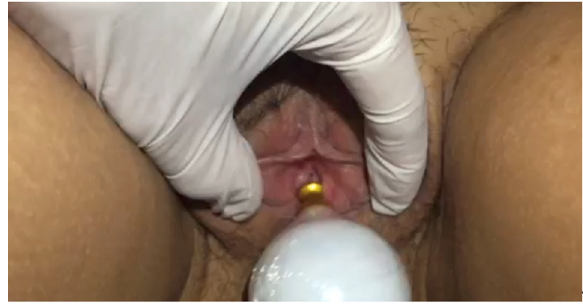
Figure 2 - Demonstration of application of non-ablative radiofrequency in external urethral